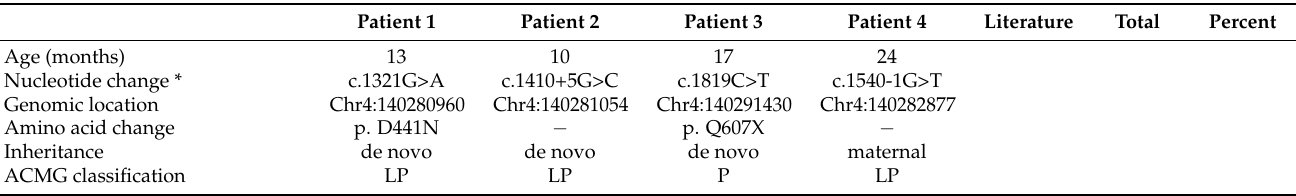
Table 1. Clinical and genetic information of patients with NAA15